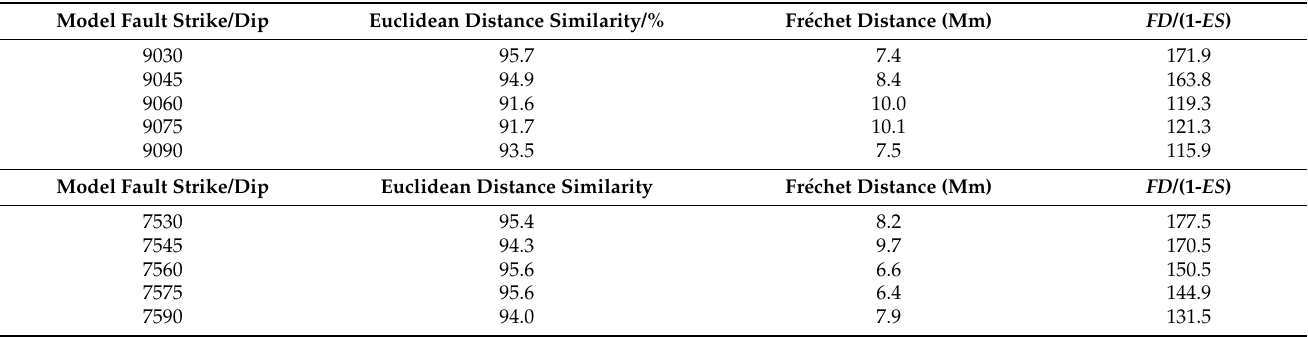
Table 4. Analyses of geometric characteristics of deformed casing sections from the models. Model Fault